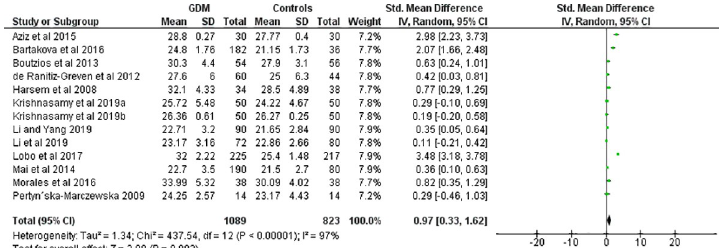
Fig 3. Forest plot depicting the BMI of women with GDM and